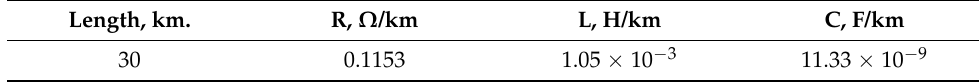
Table A2. Transmission line